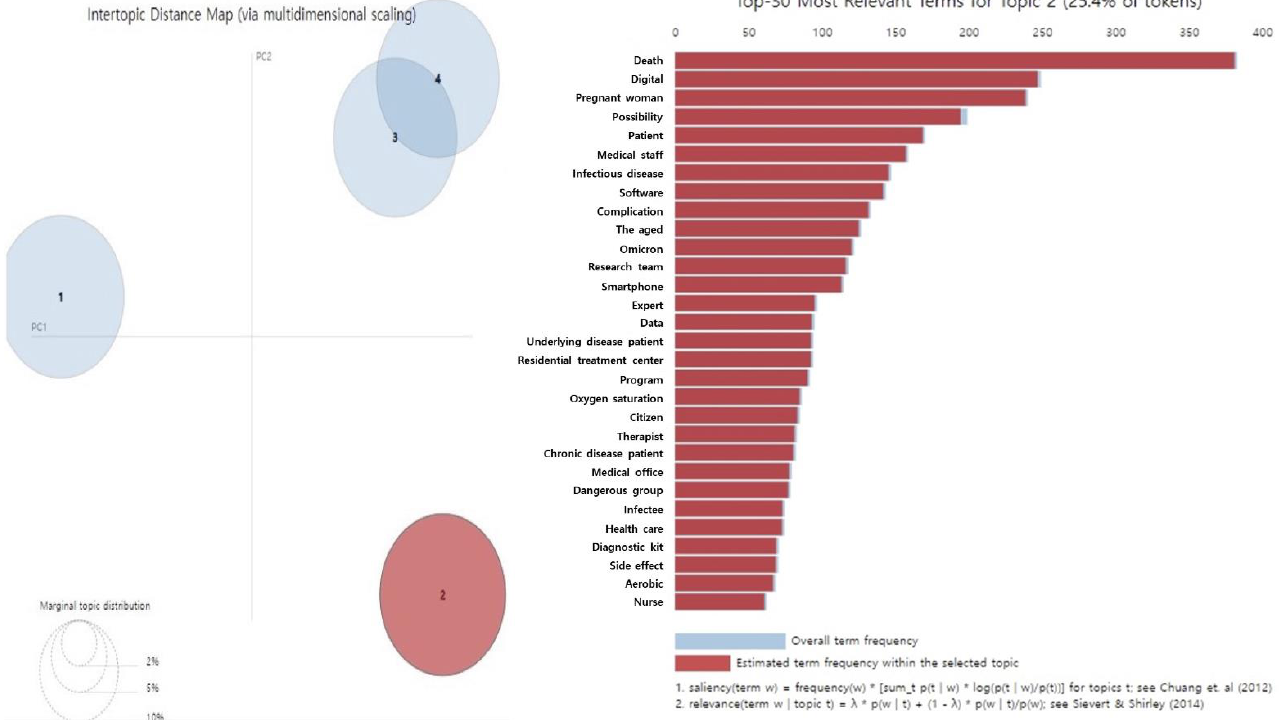
Figure 2. Results of LDA topic modeling ‘Topic 2’ in people with diabetes during the COVID -19.